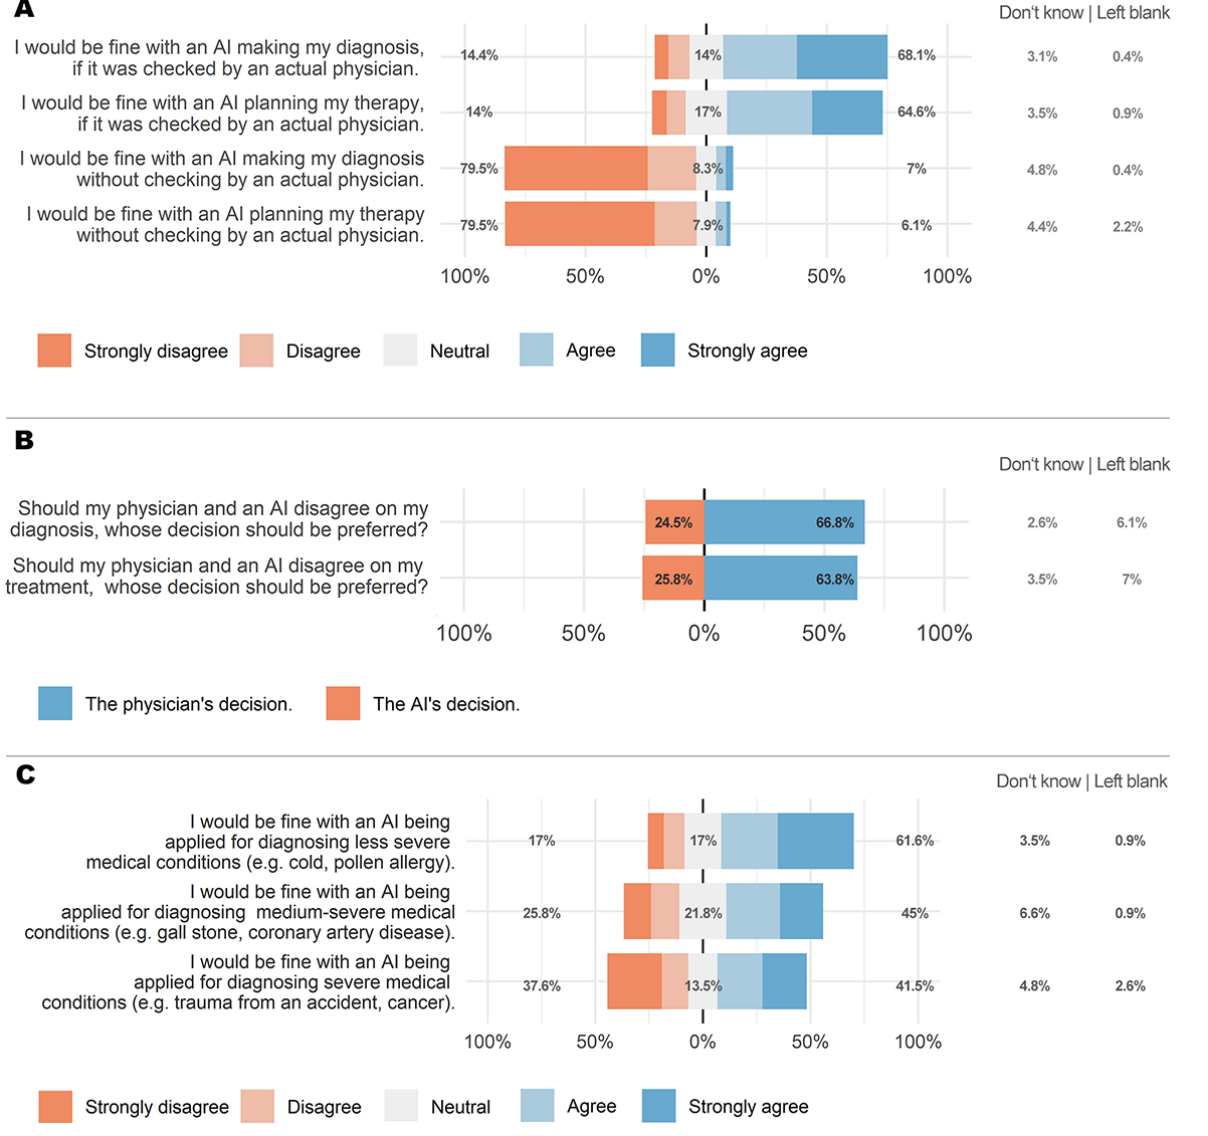
Figure 2. Results of the questionnaire regarding control of artificial intelligence (AI) (A), disagreement between AI and physicians (B), and the application of AI for diagnosing medical conditions of low, medium, and high severity (C). Percentages refer to the proportion of negative (light orange, orange), neutral (gray), and positive (light blue, blue) responses. Proportions of patients who indicated “Don’t know” or left the question blank are indicated on the